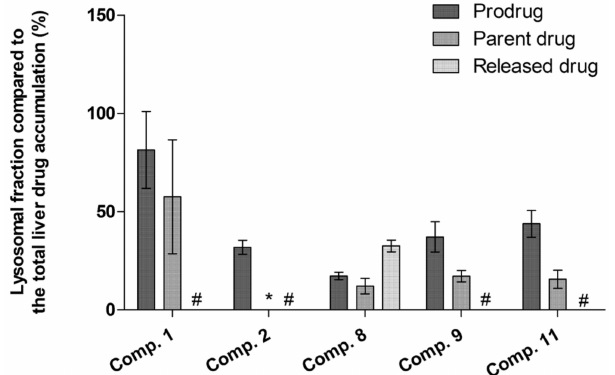
Figure 5. Liver lysosomal accumulation of prodrugs 1 , 2 , 8 , 9 , and 11 and their released parent drugs compared to the lysosomal accumulation of their parent drugs expressed as percentages (%) of total liver tissue accumulation. The liver samples were collected at the t max (10–120 min) of each prodrug according to their pharmacokinetic evaluation [28,31,41]. An asterisk (*) denotes that no parent drug was detected (compound 2 ) and hashtag (#) that no released parent drug was observed (all prodrugs except compound 8